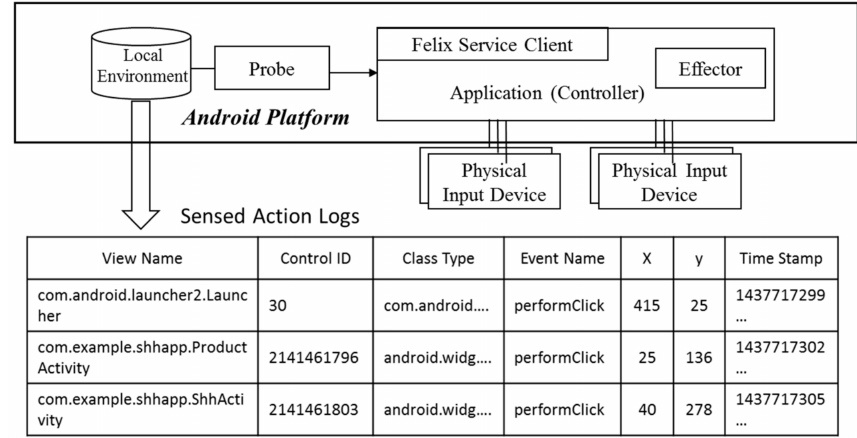
Figure 4. Generation of action logs.